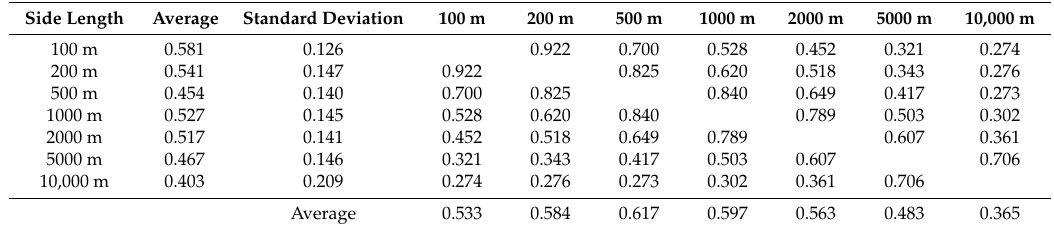
Table 14. Correlation matrix and basic statistic parameters for the 1000 m mesh control points grid. Side Length